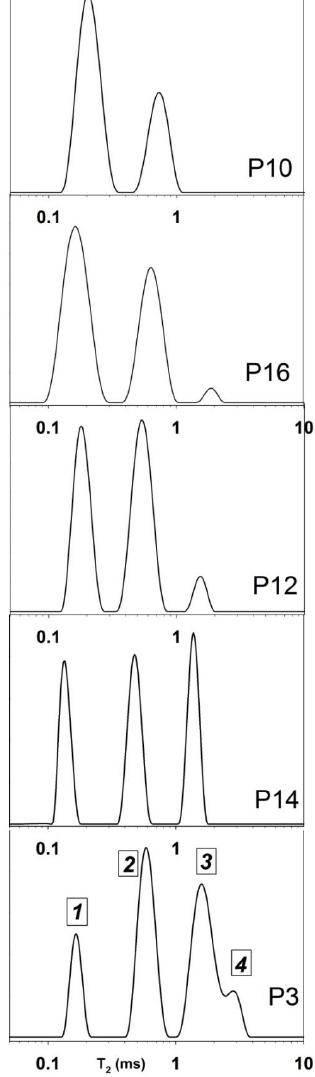
Figure 5. Transverse relaxation time distributions measured at different heights in region A of the tuff wall.